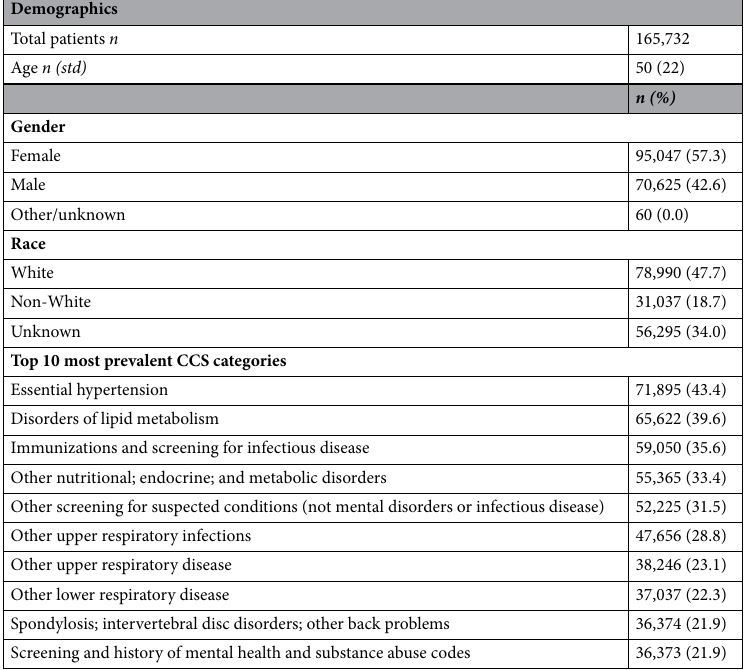
Table 1. Characteristics [mean (SD) or n (%)] of the study